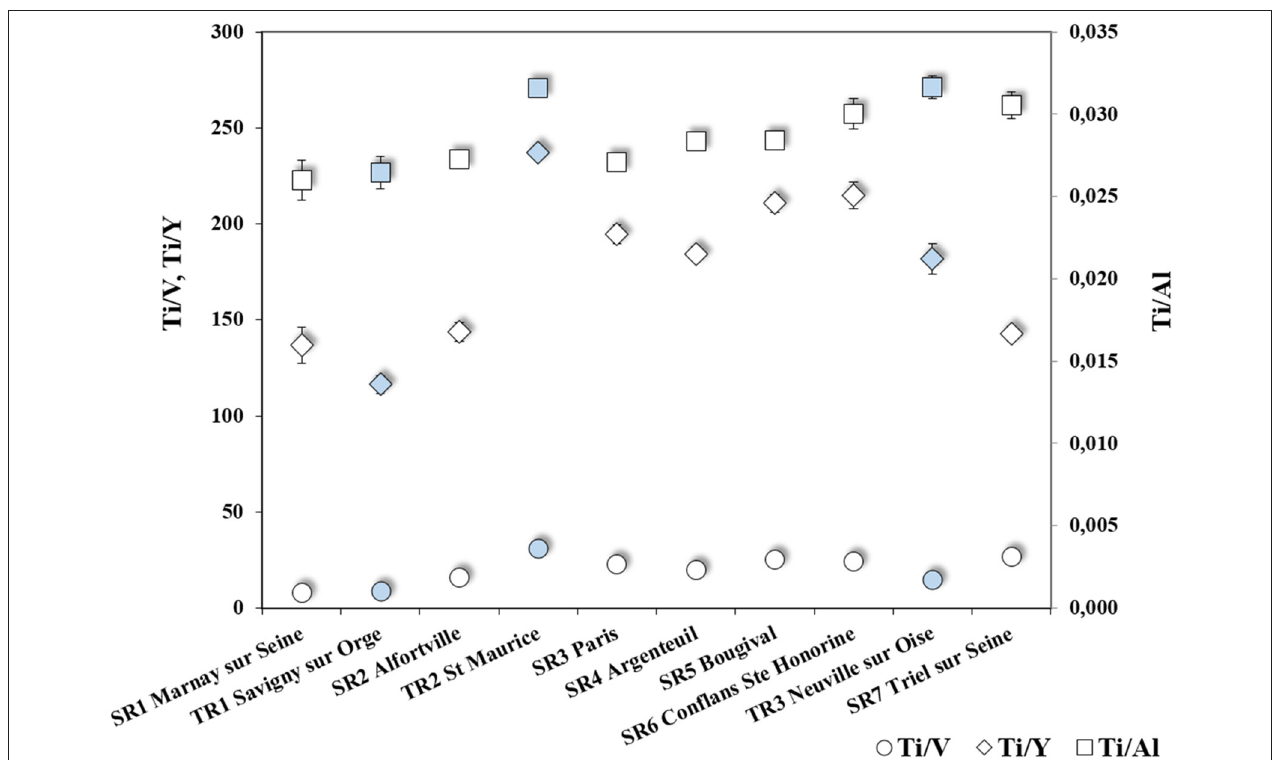
FIGURE 7 | Ti/V and Ti/Y elemental ratios (left-hand axis) as regard to Ti/Al elemental ratios (right-hand axis) evolution for the different sampling sties from SR1 to SR7 (in white), with the three different tributaries (in